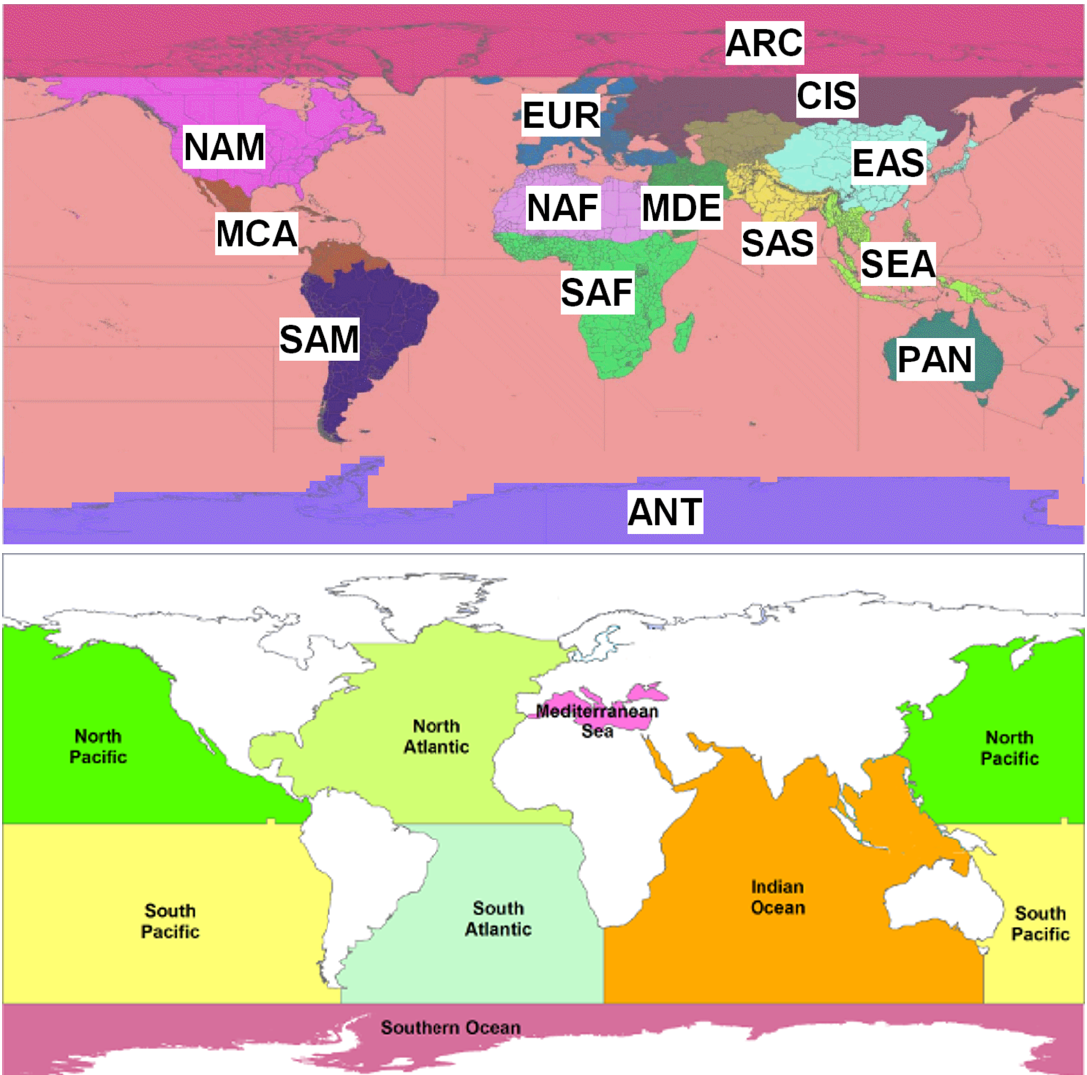
Figure 1. Upper panel: definition of the source regions used herein. NAM (North America), EUR (Europe), SAS (South Asia), EAS (East Asia), SEA (South East Asia), PAN (Australia), NAF (North Equatorial Africa), SAF (South Equatorial Africa), MDE (Middle East Asia), MCA (Central America), SAM (South America), CIS (Central Asia), ARC (Arctic, above 66 ◦ N). Lower panel: Definition of the ocean basins used here. Note that Southern Ocean and ANT are, respectively, the ocean and the Antarctic continent below 60 ◦